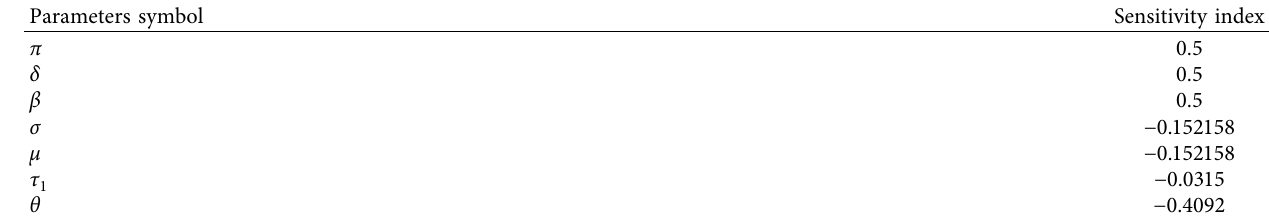
Table 2: Sensitivity indices of parameters.